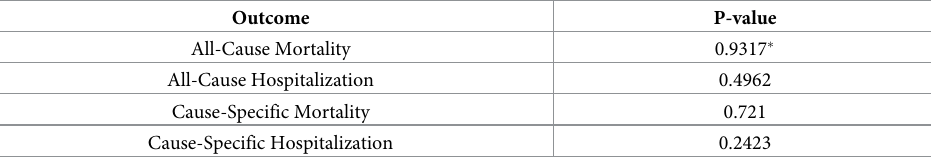
Table 4. Complexity score analysis in heart failure